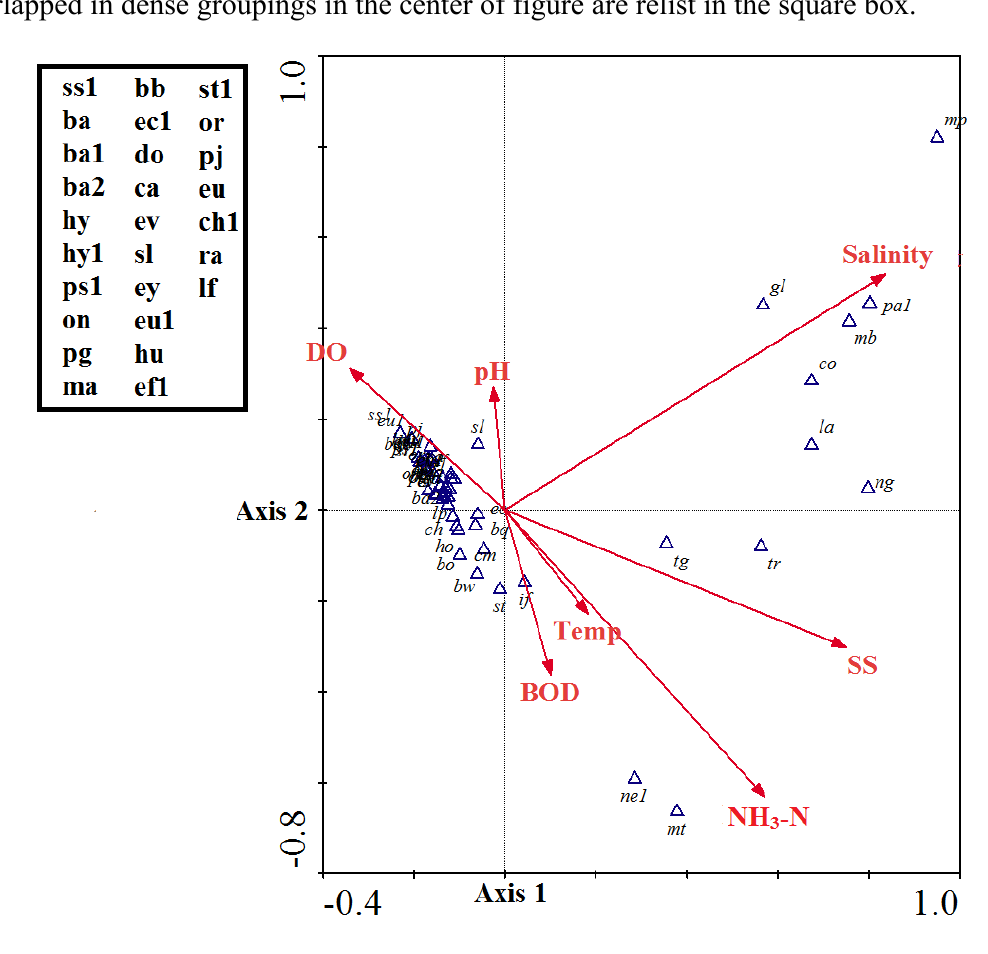
Figure 3. The environmental factors loading and their correlation to macro-invertebrates taxa of the Tanshui River system in 2012. Plot based on the regression on factor 1 and factor 2. The abbreviations used in this picture are listed in Table A2. The abbreviations overlapped in dense groupings in the center of figure are relist in the square